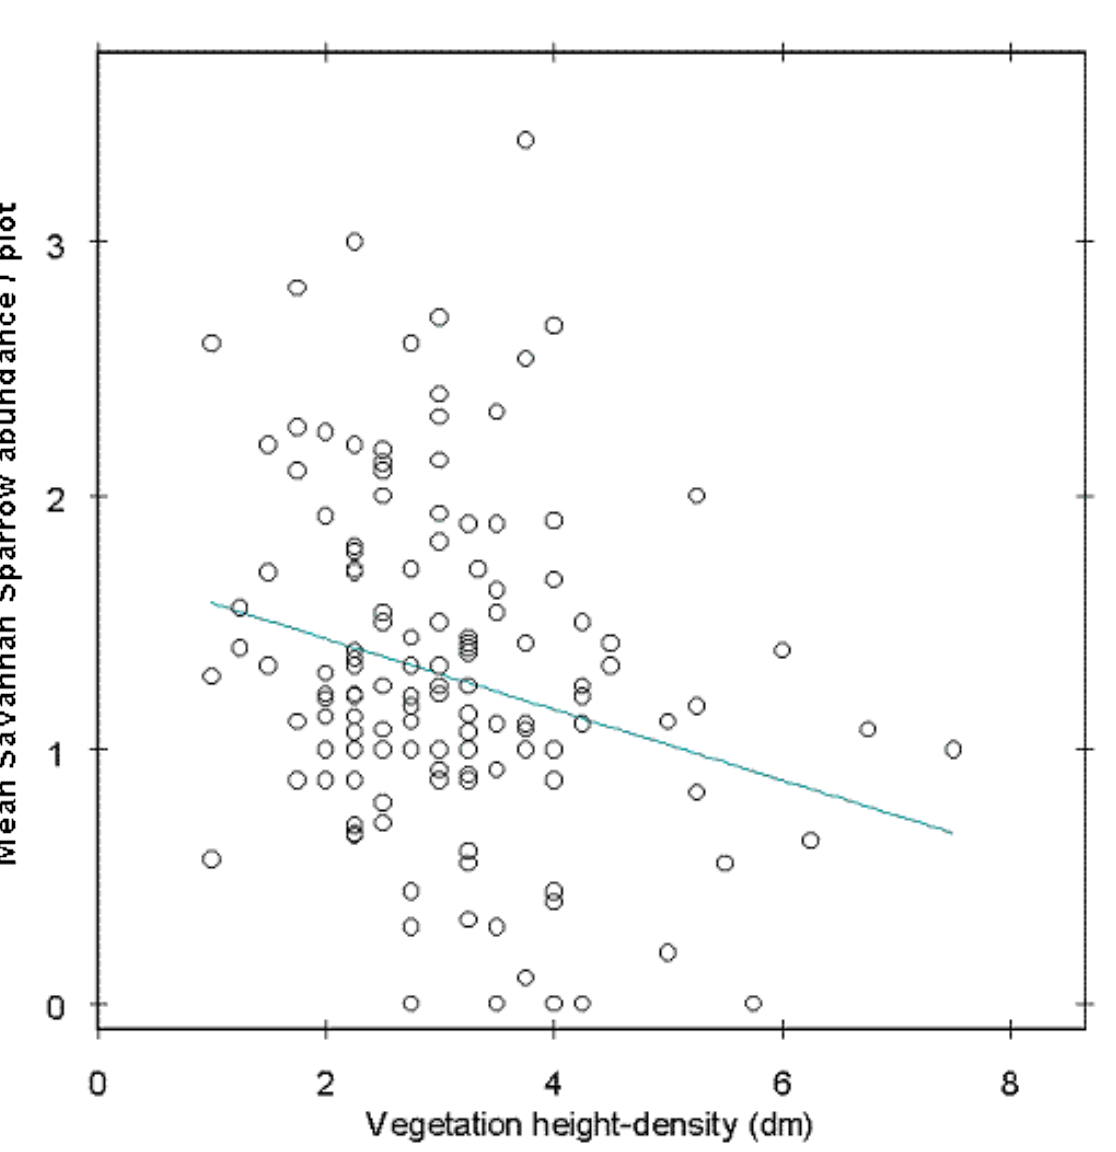
Fig. 2. Mean abundance of Savannah sparrow per point-count station as a function of vegetation height- density in dm, determined using method of Robel et al. 1970 in May. Although linear mixed-effects models were used, least-squares trendline is shown to illustrate direction of